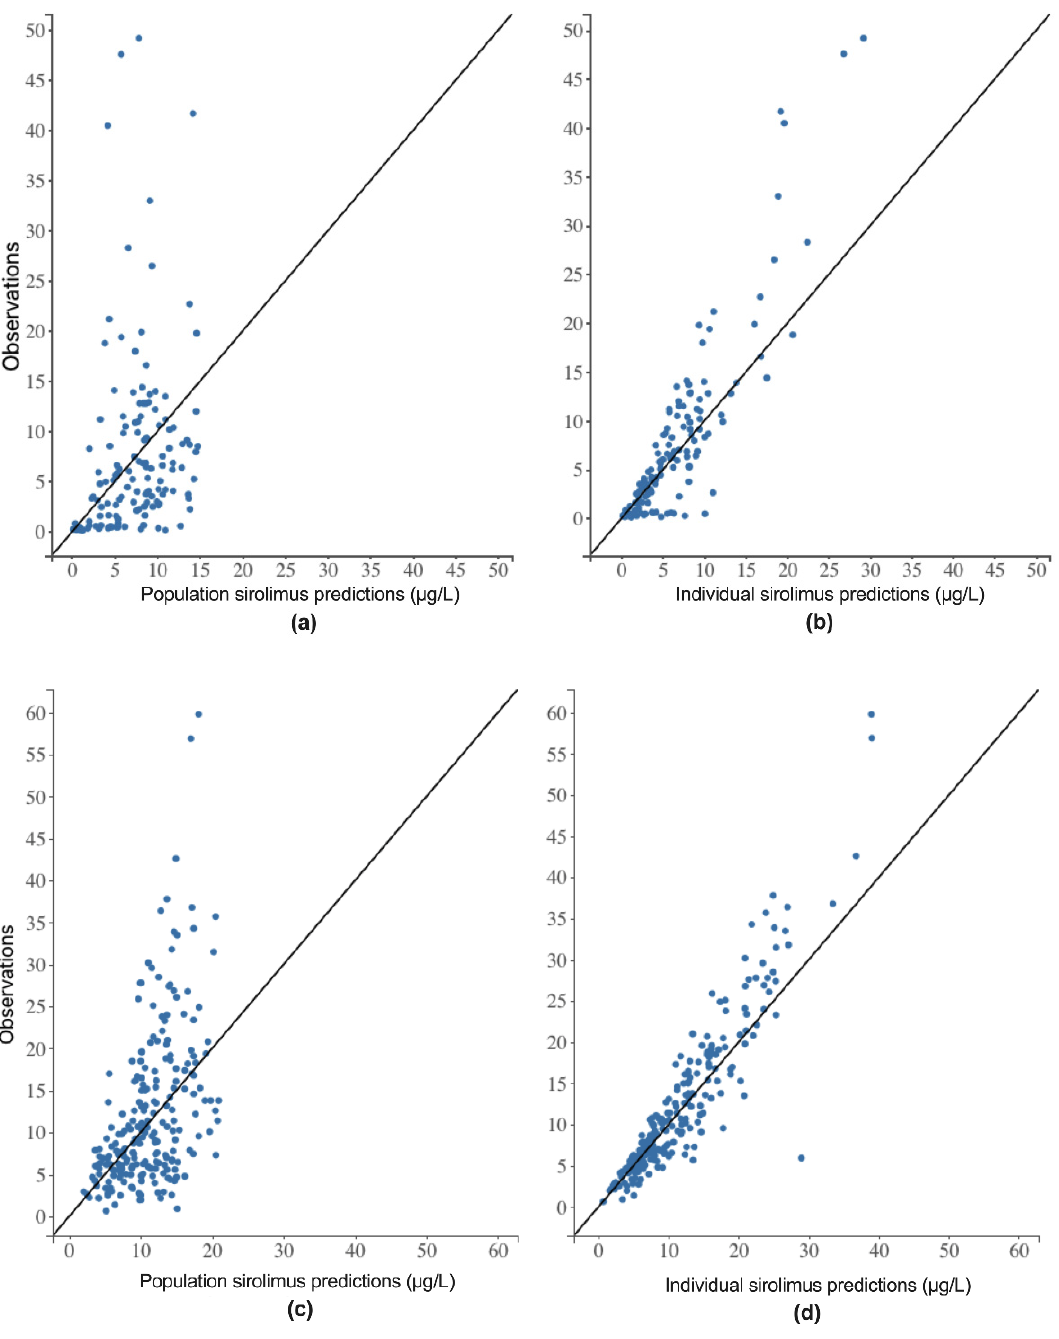
Figure 1. Goodness of fit plots. Observed concentrations versus population predicted concentrations on day 1 (D1) ( a ) and day 8 (D8) ( c ). Observed concentrations versus individual predicted concentrations on D1 ( b ) and D8 ( d ). Black line: y = x.